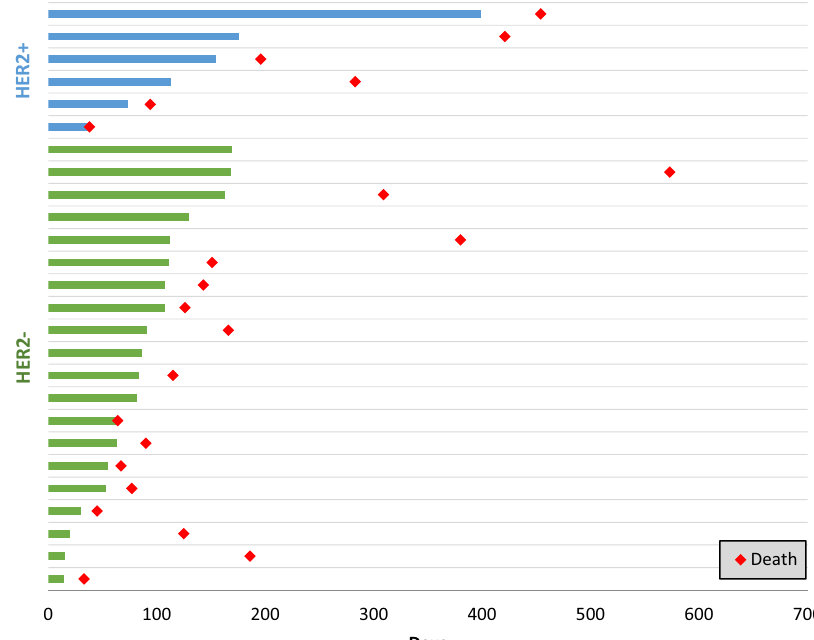
Fig. 2 Swimmer ’ s plot. The Swimmer ’ s plot illustrates time on treatment in blue and green for the HER2 + and HER2- cohorts, respectively. Time of death is indicated by the red